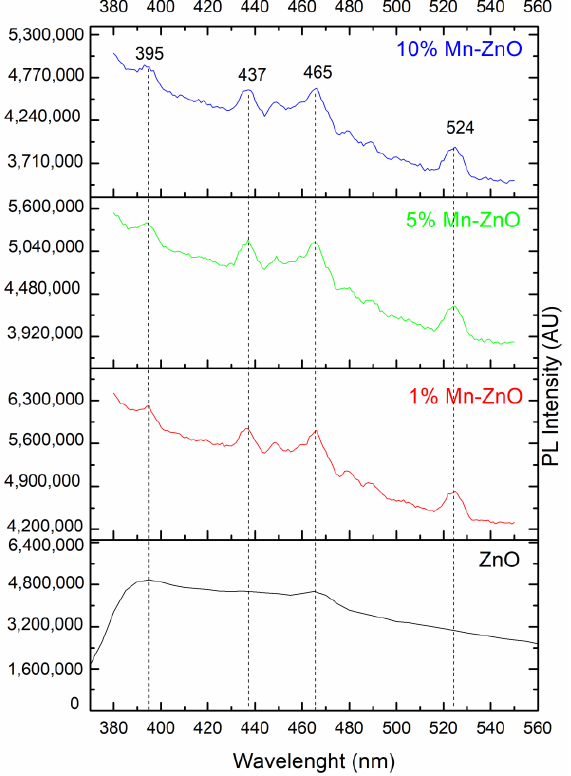
Figure 5. PL spectra of pure and Mn-doped ZnO nanomaterials.